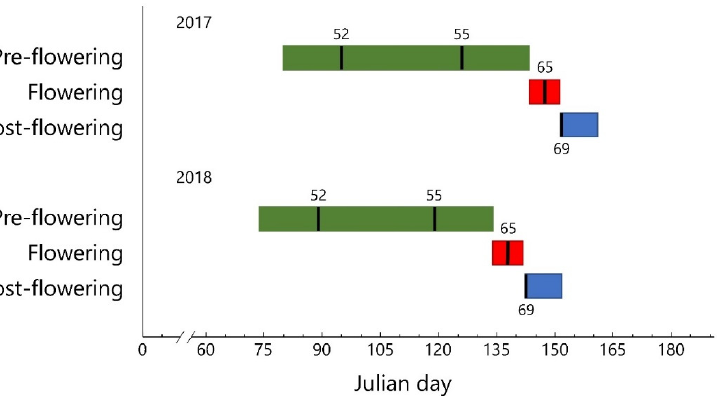
Figure 2. Phenological stages recorded in spring 2017 and 2018 on olive trees (average of all clones) according to the BBCH scale [30]. Green, red and blue boxes indicate the pre ‐ flowering, flowering and post ‐ flowering period, respectively. BBCH codes: 52 (start of flower cluster development); 55 (flower cluster totally expanded); 65 (full flowering); 69 (end of flowering, fruit set).